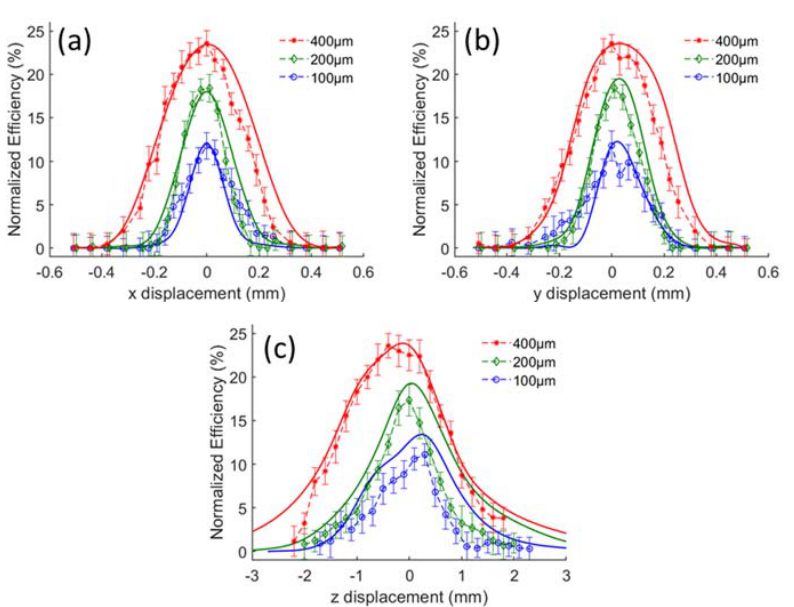
Figure 10. Raman efficiency of our setup with respect to misalignments of the MMF along Figure 10. Raman e ffi ciency of our setup with respect to misalignments of the MMF along ( a ) x-, ( b ) y-, ( a ) x ‐ , ( b ) y ‐ , ( c ) z ‐ axis, respectively. 100, 200 and 400 μ m MMFs are used. ( c ) z-axis, respectively. 100, 200 and 400 µ m MMFs are